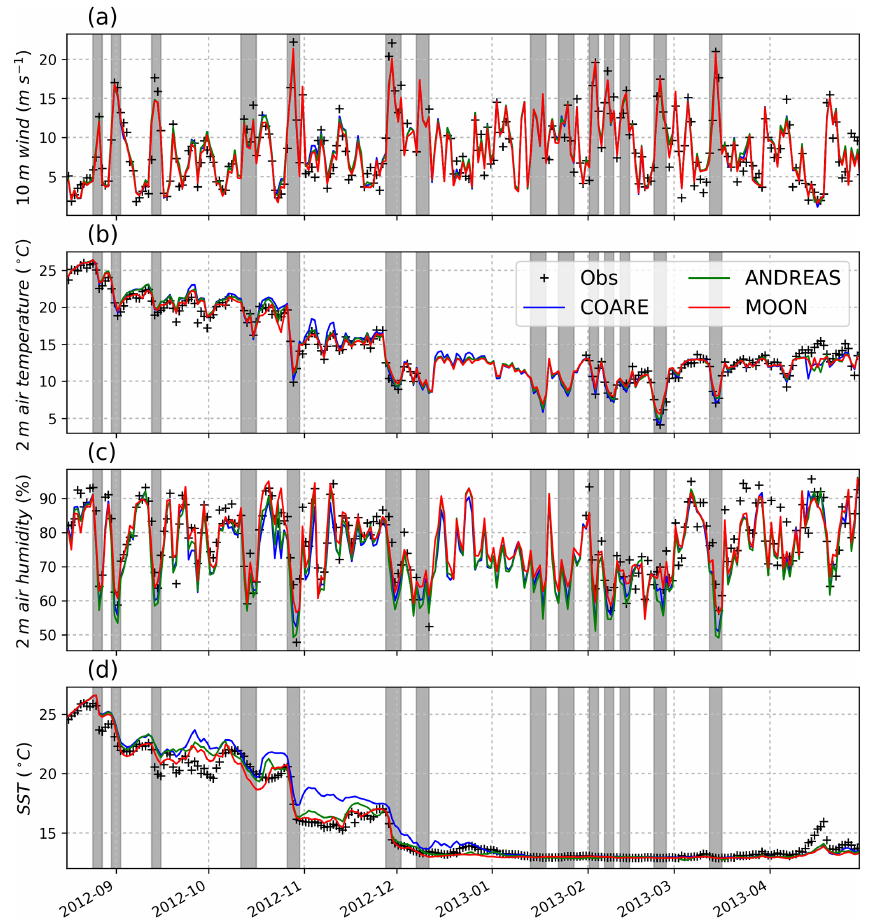
Figure 4. Time series of (a) the 10m wind speed, (b) the 2m air temperature, (c) the 2m air humidity and (d) the sea surface temperature measured at the Lion meteorological buoy (in black) and computed by each simulation (COARE in blue, ANDREAS in green and MOON in red). The grey bars correspond to the strong wind periods (hourly wind speed > 15ms − 1 ). Table 2. Statistics of surface atmospheric and oceanic parameters at the Lion meteorological buoy. Exp. COARE ANDREAS MOON Stat. Bias rms R Bias rms